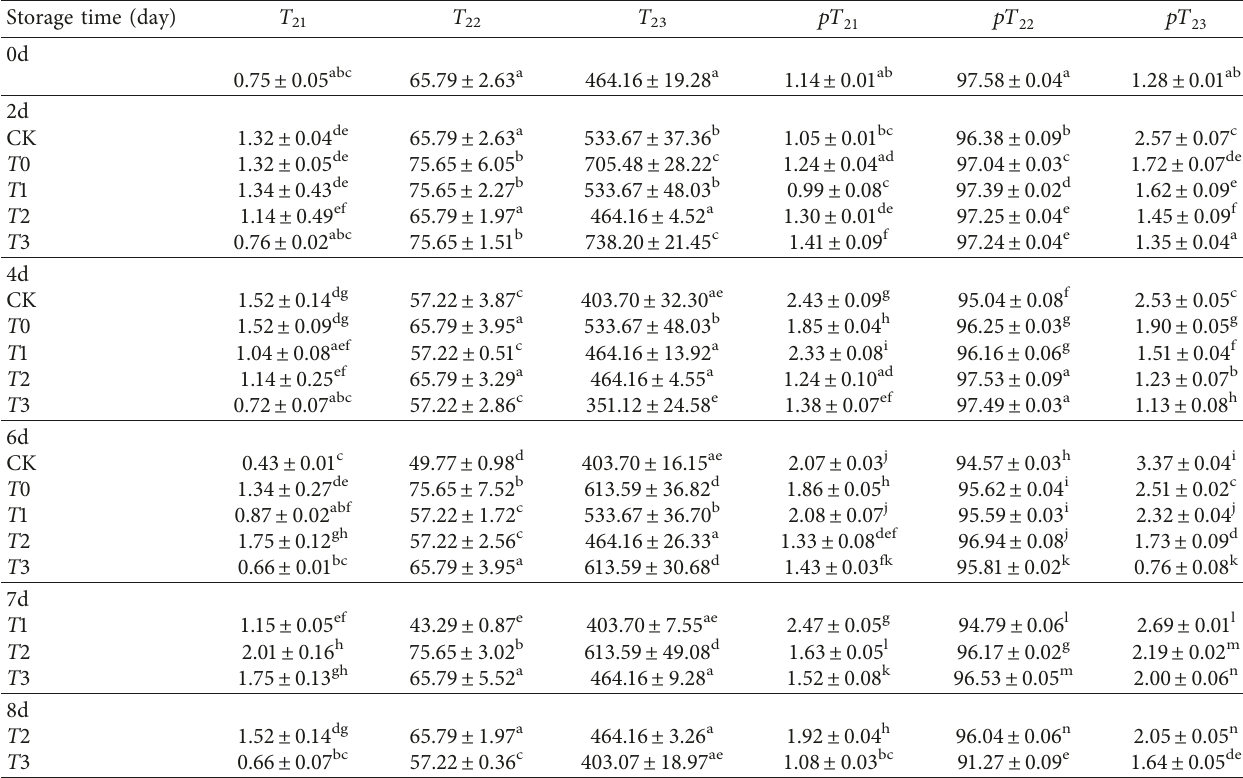
Means in the same column with different letters are significantly different ( p < 0 .